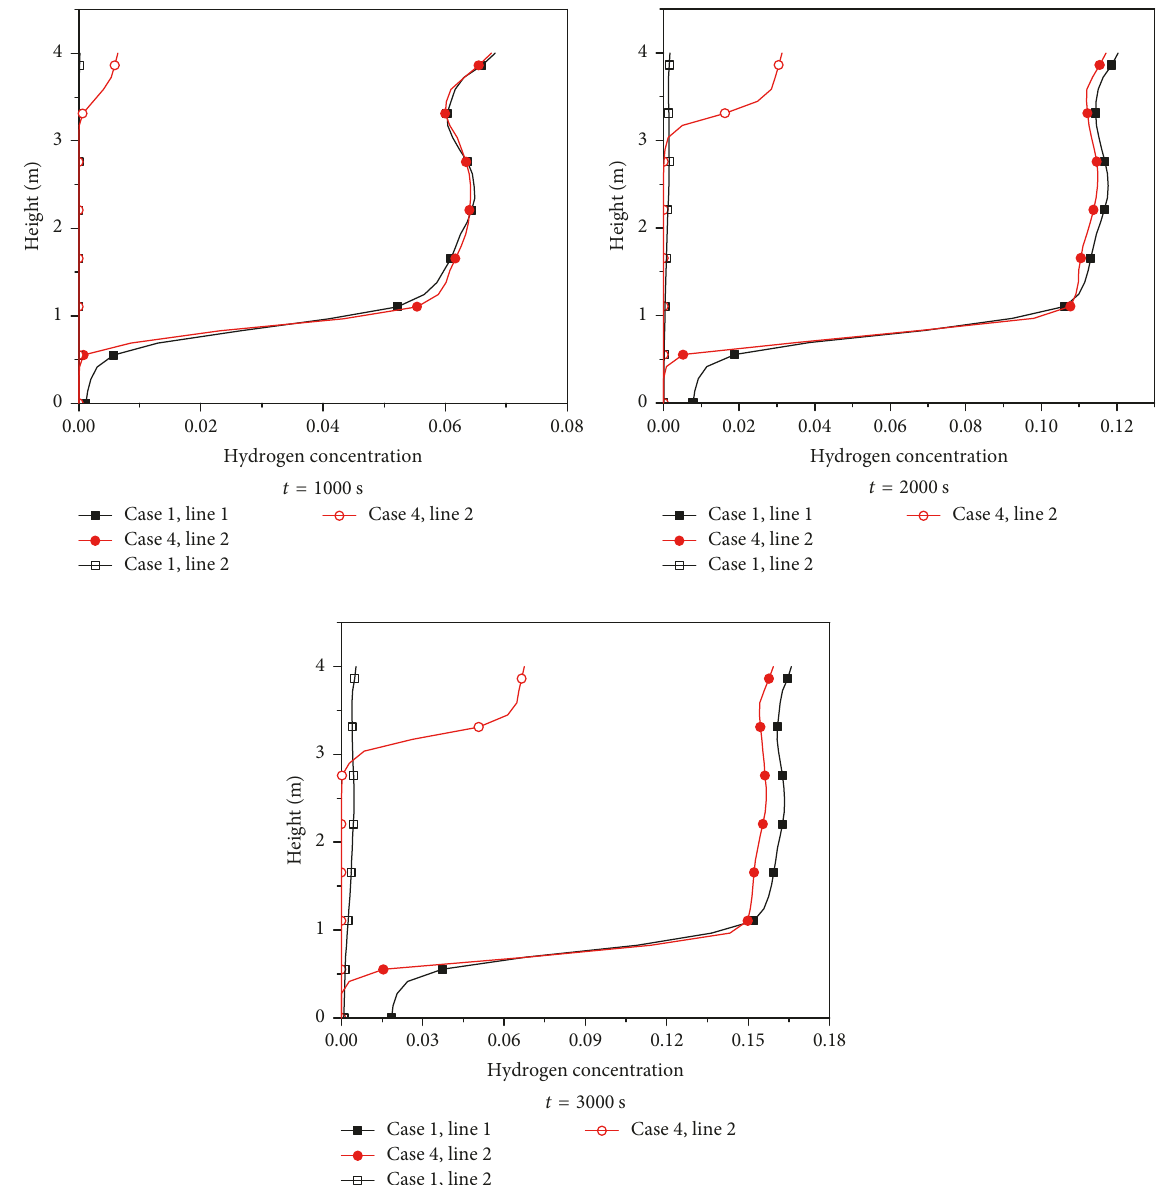
Figure 11: Hydrogen concentration at different positions in the